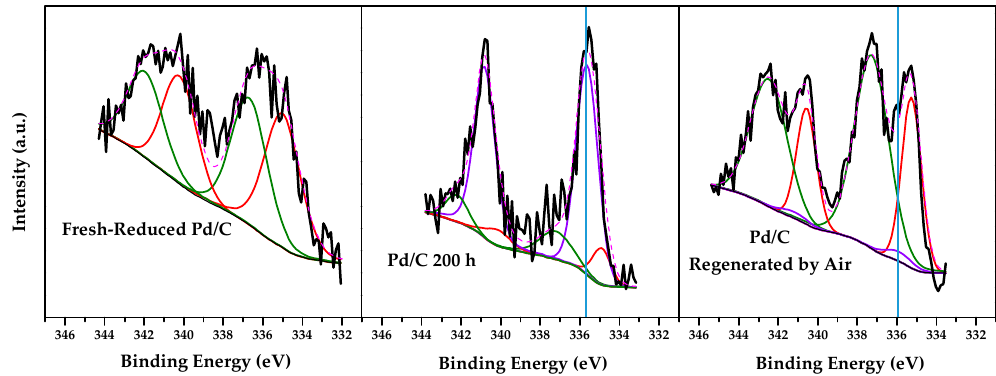
Figure 6. XPS patterns in the Pd 3d region of the Pd / C catalysts from the deactivation–regeneration study ( τ = 0.40 kg h mol − 1 ) (the overall Pd 3d spectra (black); Pd 0 spectra (red); Pd n + spectra (green); PdC x spectra (violet); overall fitting line spectra (dash); the blue vertical line indicates the position of the peak of PdC x spectra).